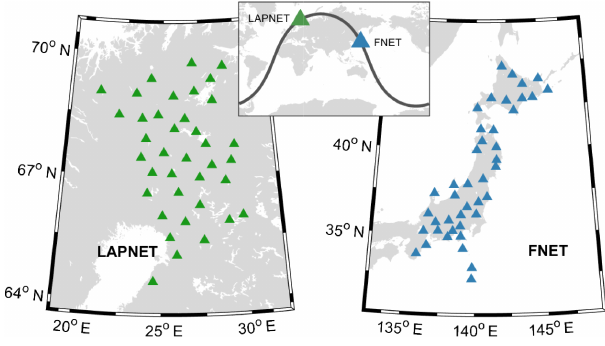
Figure 1. Geographic locations of the 38 stations of the LAPNET array in Finland and the 41 stations of the FNET array in